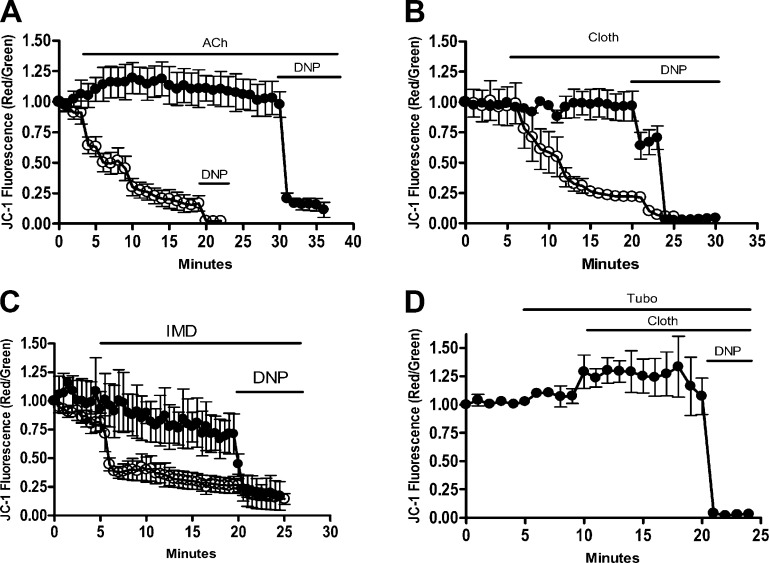
Bumblebee brain neurons undergo mitochondrial depolarization when nAChR are hyperstimulated. A) Bumblebee neurons in culture undergo mitochondrial depolarization in the presence of high levels (1 mM; open circles) but not low levels (100 μM; filled circles) of acetylcholine. The neonicotinoid, clothianidin (B), induces mitochondrial depolarization at 10 nM (open circles) but not at 1 nM (filled circles), and imidacloprid (C) induces mitochondrial depolarization at 1 µM (open circles) but not at 10 nM (filled circles). (D) Neurons pre-exposed to the nAChR antagonist d-tubucurarine (500 μM) do not undergo mitochondrial depolarization in the presence of clothianidin (100 nM), demonstrating an nAChR-dependent process. In all cases, mitochondrial depolarization was monitored using ratiometric (red/green) JC-1 imaging, and the experiment was terminated by full mitochondrial depolarization using 2,4-dinitophenol (1 mM). In all cases, 15–20 regions of interest were monitored (n = 3).